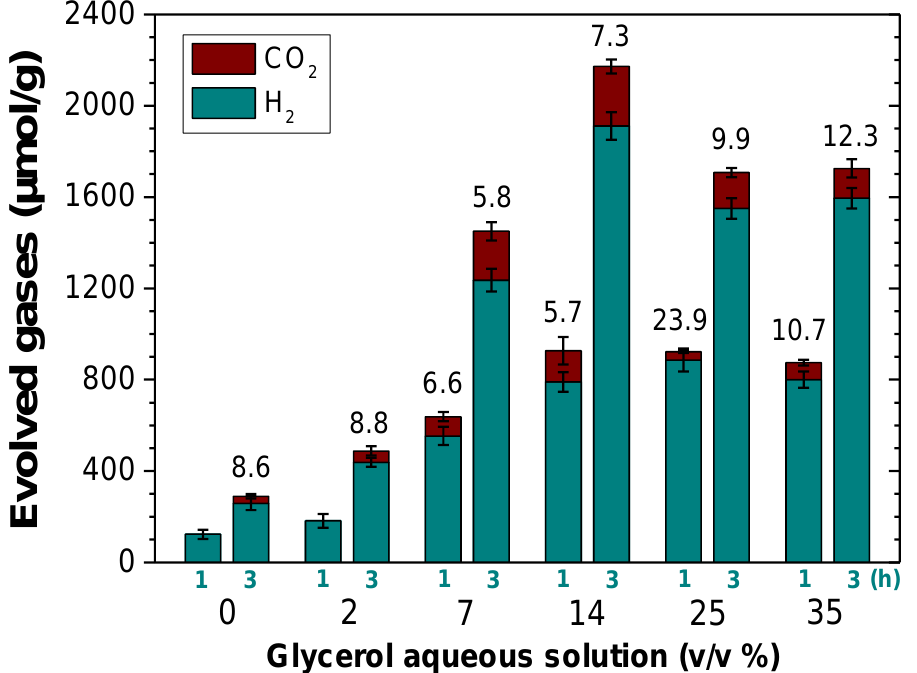
Figure 6. Influence of the glycerol aqueous solution concentration on the photocatalytic H 2 and CO 2 generation using UiO-66(Zr)-NH 2 . The numbers indicated above the bars correspond to the H 2 -to-CO 2 molar ratio. Reaction conditions: Photocatalyst (5 mg), H 2 O:glycerol mixture (20 mL; vol% as indicated), reaction time (as indicated), simulated sunlight irradiation (230 W/cm 2 ), 35 °C.